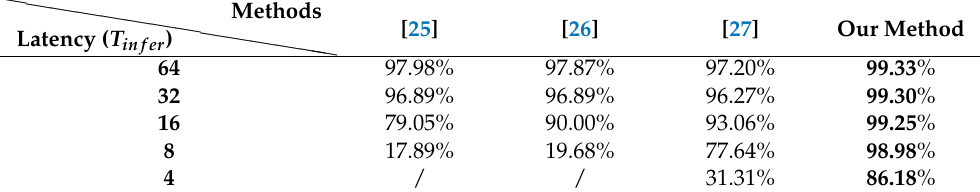
Table 2. Classification accuracies vs. latencies for the compared methods on the MNIST dataset.